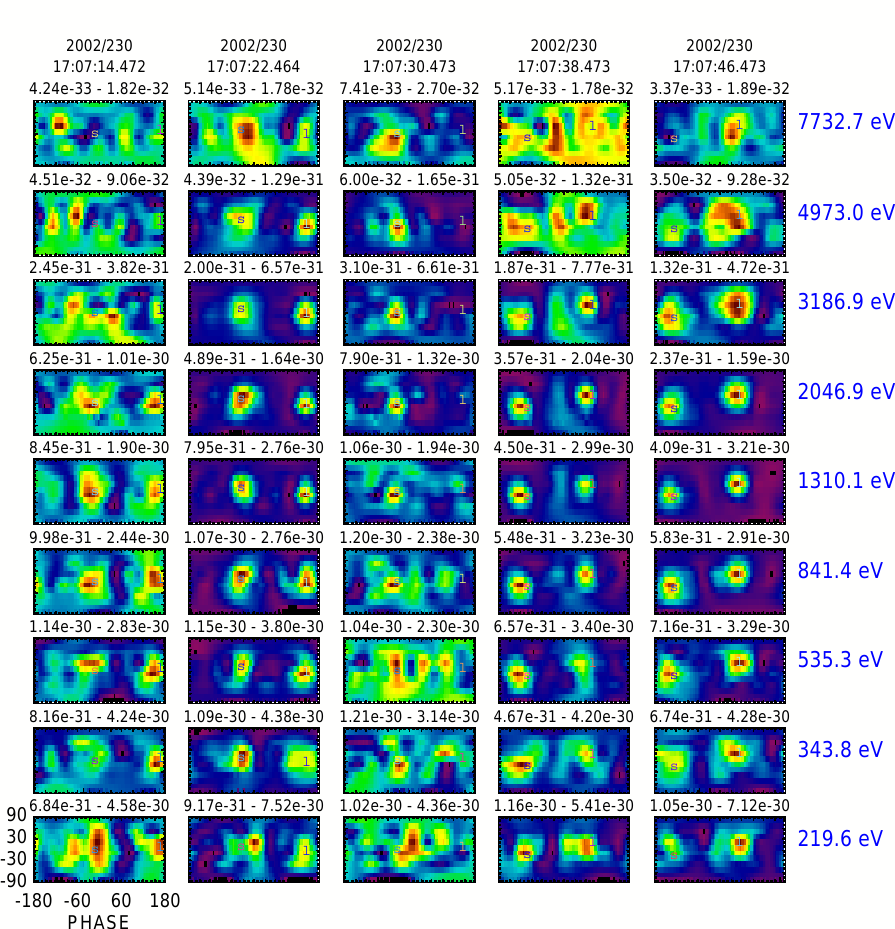
Fig. 4. A set of phi/theta plots of the eVDF in units of s 3 cm − 6 during the first vorticity enhancement in event 2. Each column shows data from multiple energy steps from a single eVDF. The energy step of each row is shown at the extreme right. The beginning accumulation time of each eVDF is shown at the top of each column and the used scaling range above each plot.The existence of bi-directional beams is clearly seen as localized enhancements in the eVDF centered on both of the magnetic field projections (circle and